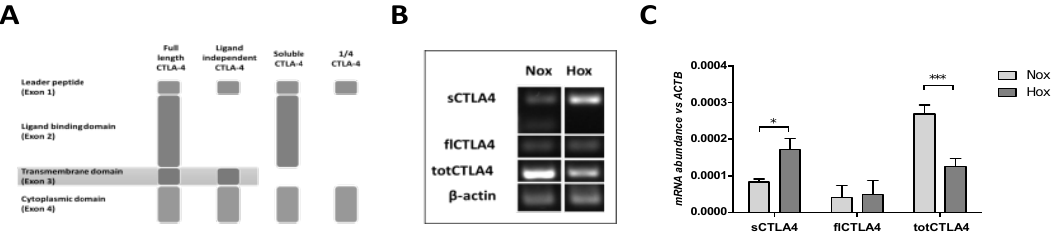
Figure 1. Mesenchymal stem/stromal cells (MSCs) differentially express distinct splice variants of cytotoxic T lymphocyte antigen 4 (CTLA-4) with regard to oxygen availability. ( A ) Scheme of the documented splice variants of total CTLA-4 (totCTLA-4)—full length CTLA-4 (flCTLA-4), ligand-independent CTLA-4, soluble CTLA-4 (sCTLA-4), and 1/4 CTLA-4—which were detectable in ( B ) conventional RT-PCR and ( C ) quantitative RT-PCR under normoxia (Nox; 18% O 2 ) and hypoxia (Hox; 1% O 2 ). Data in ( C ) are given as the mean ± SEM (statistical analysis: two-way ANOVA with Bonferroni’s post hoc test: * p < 0.05, *** p < 0.001).